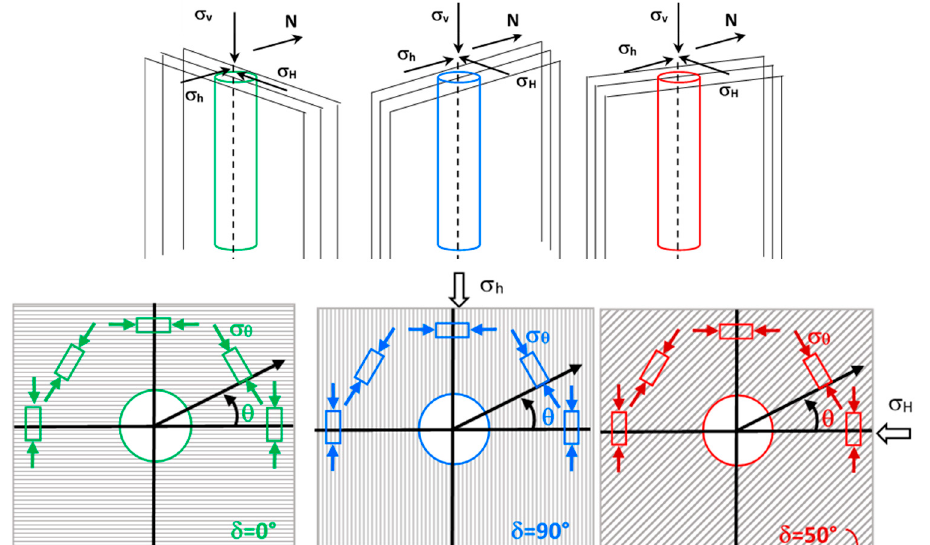
Figure 1. Examples of vertical boreholes drilled parallel to vertical weakness planes, which are characterized by different orientations. The inclination δ of the weakness planes in the cross section is measured counterclockwise from the maximum in situ principal stress.